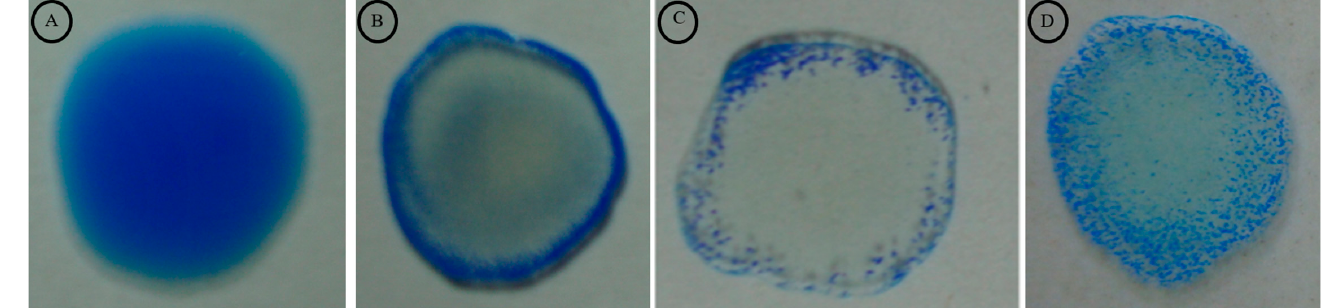
8 of 14 Figure 2. Recombinant LigA/BCon1-5 antigen-based IgM Dot ELISA Dipstick Test (IgM DEDT) for the detection of anti-leptospiral antibodies in human sera. ( A , B ): Low intensity blue dots by human sera which showed seroconversion (0 to ≥ 100); ( C , D ): Moderate intensity blue dots by human sera which showed a four-fold rise in the MAT titre ( ≥ 50 to ≥ 200); ( E , F ): High intensity blue dots by human sera which showed a positive reaction in the single acute MAT (MAT titre ≥ 400); ( G ): Known positive human sera ( H ): Known negative human sera 3.4. Latex Agglutination Test and Correlation between MAT Titre and LAT Score The latex agglutination test (LAT) showed a clear-cut agglutination with positive sera, which can be visualized easily (Figure 3b–d), and can clearly differentiate negative sera showing homogeneous suspension (Figure 3a). A positive correlation exists between the MAT titre and LAT score. Human sera ( n = 51), which showed a positive reaction in the single acute MAT (MAT titre ≥ 400) gave a LAT score of 3+ (Supplementary Table S2A), which meant that a high intensity of agglutination occurred almost instantaneously (usually <30 s) upon the addition of serum samples, which is evident in the form of tiny flakes (Figure 3d). Human sera ( n = 4), which showed a four-fold rise in the MAT titre ( ≥ 50 to ≥ 200) gave a LAT score of 2+, and the agglutination occurred between 30 s and 1 min